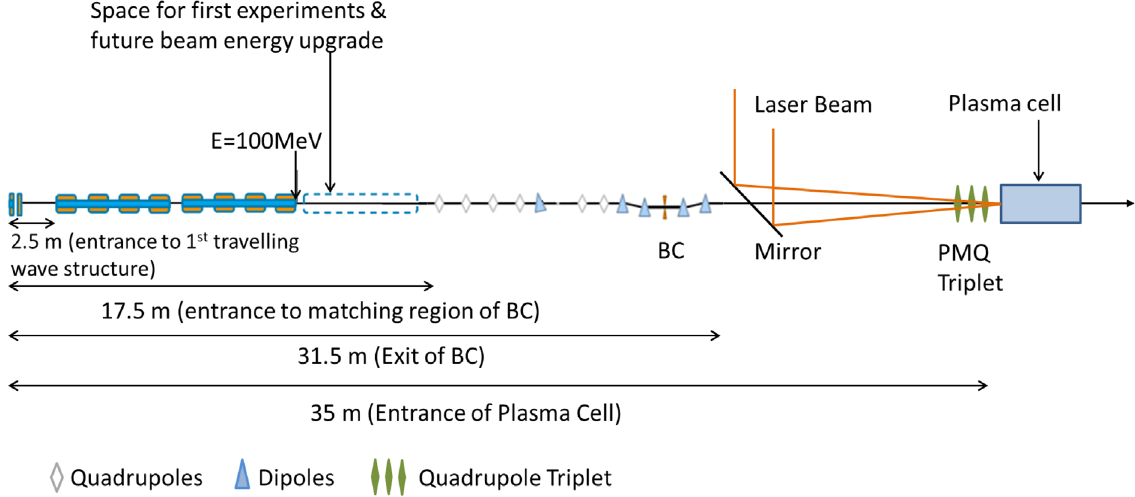
FIG. 1. Schematic of the ARES beam line including injection into an LPA (not to